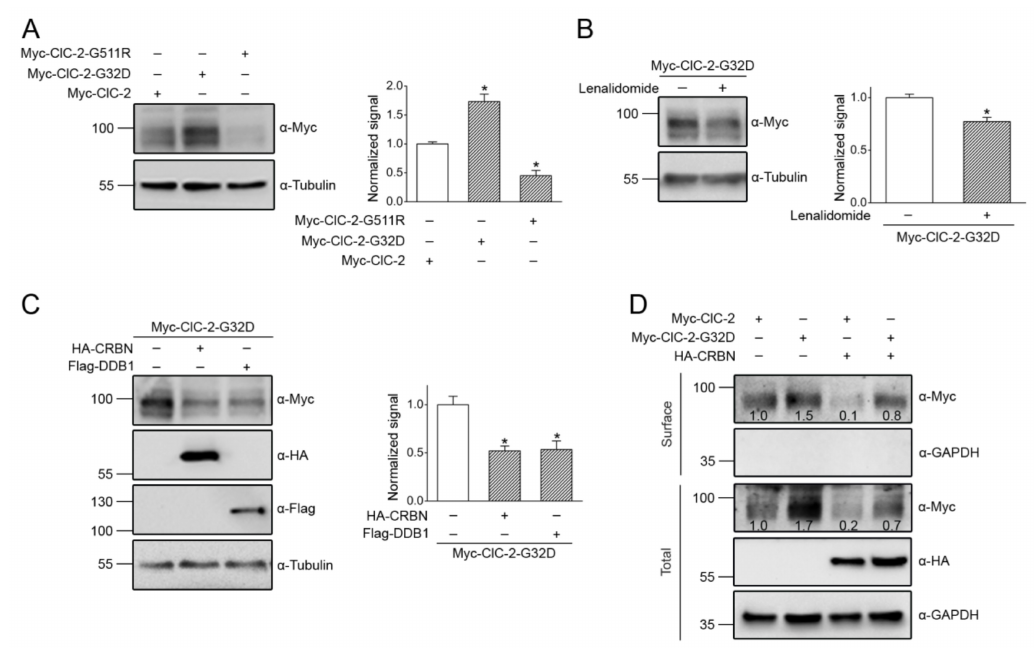
Figure 10. Aldosteronism-associated gain-of-function alteration in ClC-2 proteostasis. ( A ) ( Upper panel ) Representative immunoblot comparing the protein expression of Myc-ClC-2 WT, aldosteronism-related G32D mutant, and leukodystrophy-related G511R mutant overexpressed in HEK293T cells. ( Lower panel ) Quantification of relative ClC-2 protein levels. Protein density was standardized as the ratio of the ClC-2 signal to the cognate tubulin signal. Values from the mutant groups ( hatched bars ) were then normalized to those for the corresponding WT control ( clear bars ). Asterisks denote a significant di ff erence from the WT (*, t test: p < 0.05; n = 7–9). ( B ) ( Upper panel ) Representative immunoblot showing the e ff ect of the 24-h treatment of 10 µ M lenalidomide on the Myc-ClC-2 G32D mutant. ( Lower panel ) Quantification of the relative ClC-2 G32D protein levels (*, t test: p < 0.05; n = 7). ( C ) ( Upper panel ) Representative immunoblot showing the e ff ect of HA-CRBN or Flag-DDB1 co-expression on the Myc-ClC-2 G32D mutant. ( Lower panel ) Quantification of the relative ClC-2 G32D protein levels (*, t test: p < 0.05; n = 4–6). ( D ) Representative immunoblot showing the enhanced surface expression surface-biotinylated intact HEK293T cells were subject to either direct immunoblotting analyses ( Total ) or streptavidin pull-down prior to immunoblotting ( Surface ). The numbers on the immunoblot denote the relative ClC-2 protein